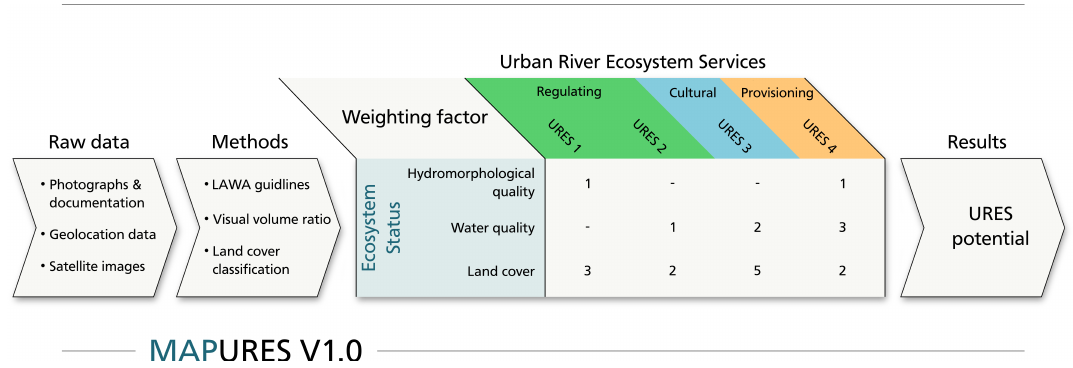
Figure 2. Methodology MAPURES V1.0 to assess the ecological status and the potential to provide ecosystem services of urban